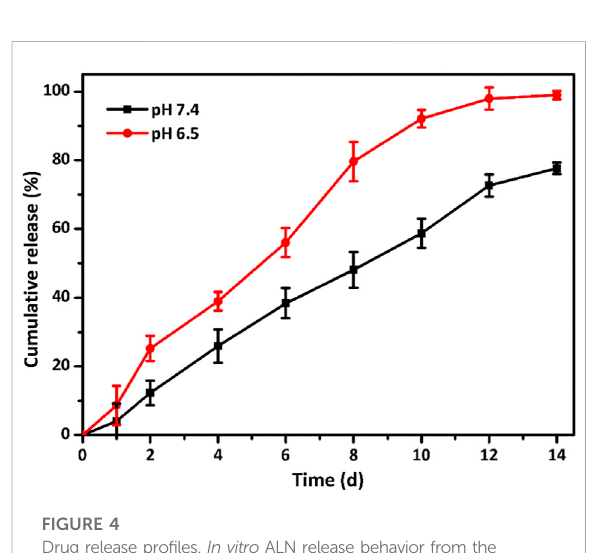
FIGURE 4 Drug release pro fi les. In vitro ALN release behavior from